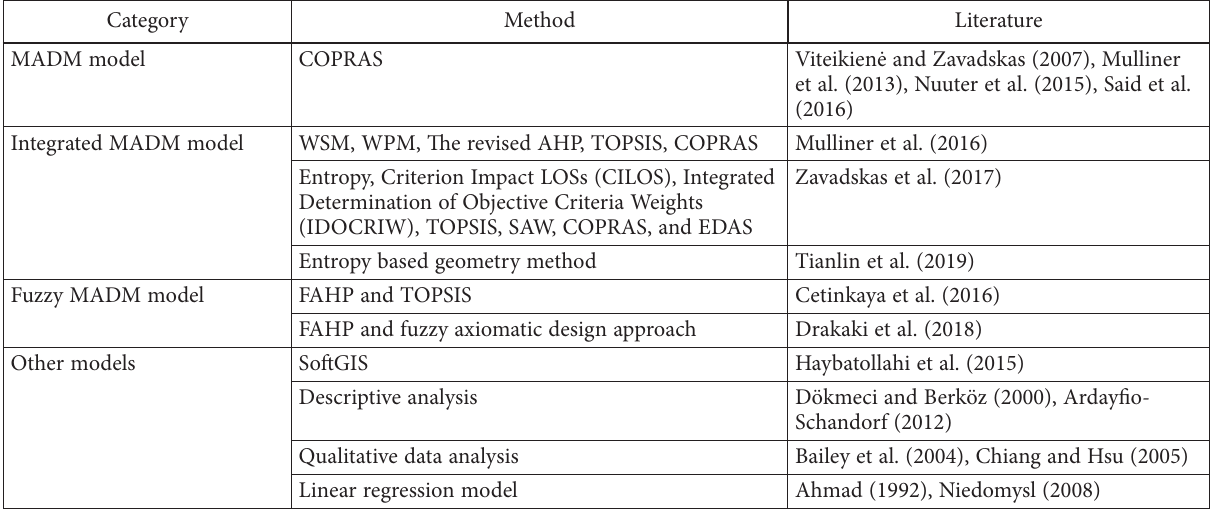
Table 1. The summary of the methods employed in making a neighborhood